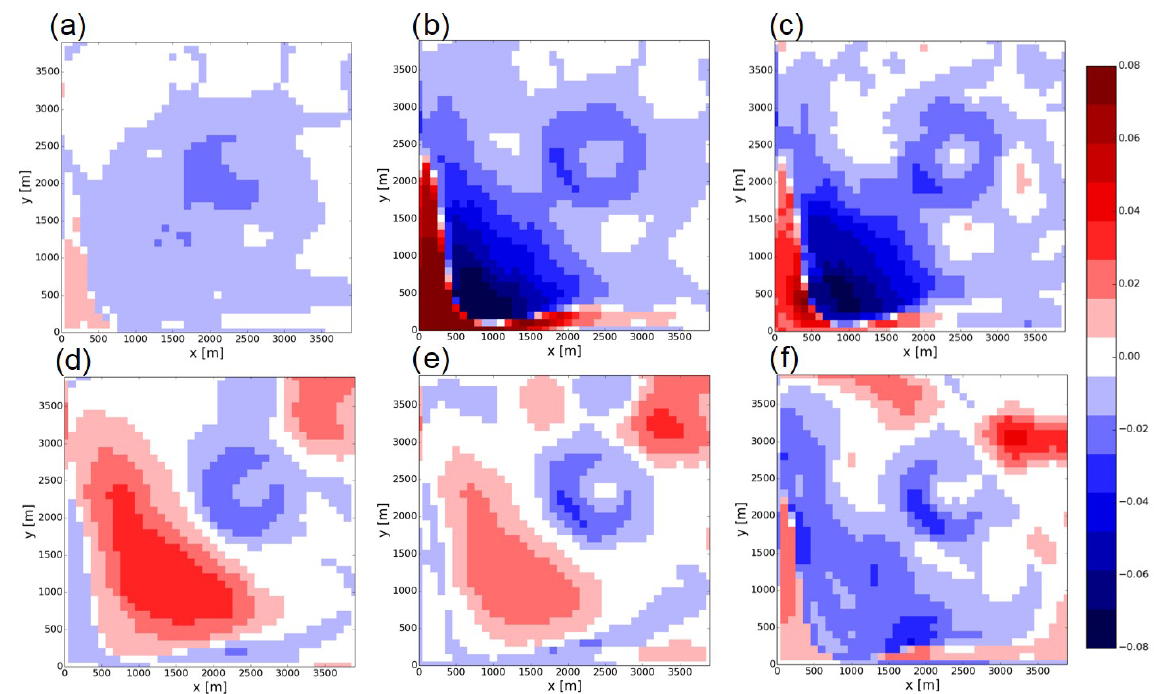
Figure 9. Differences of time-mean soil moisture RMSEs between the DA experiments and the OF_NoDA experiment. (a) OF_DA_obs1,